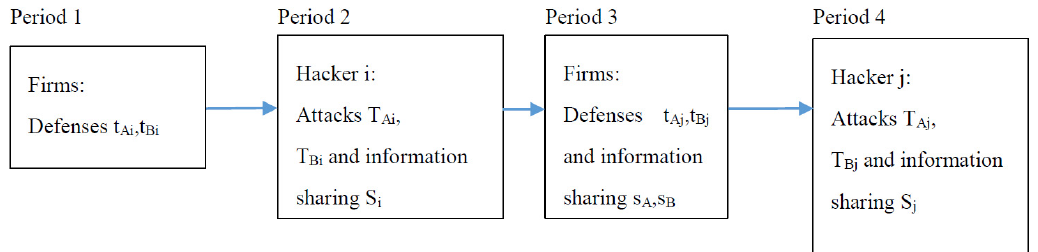
Figure 1. Four period game.